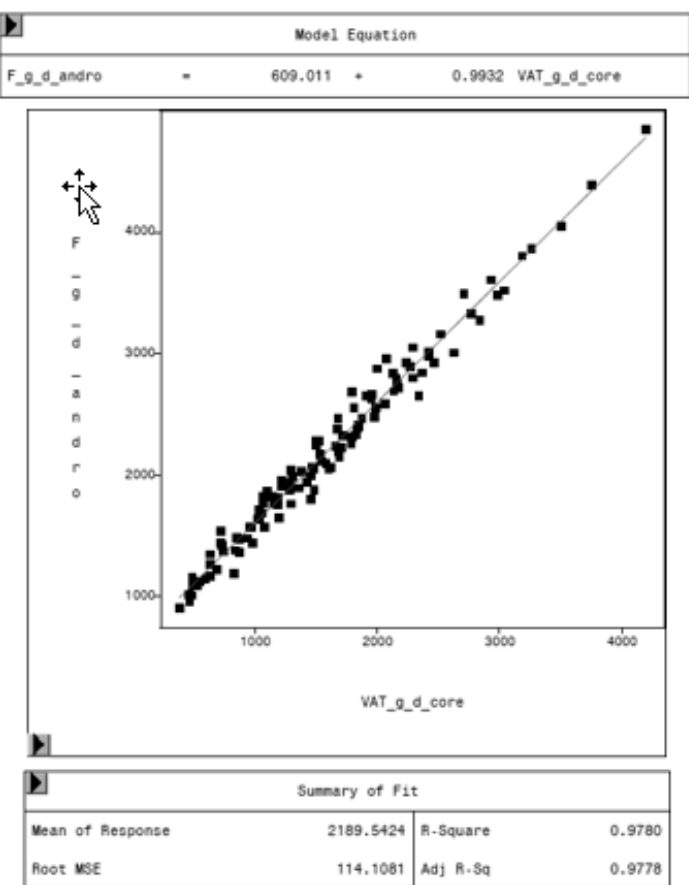
Figure 7. Relationship between fat mass in the android region (F_g_d_andro, in g) and VAT mass (VAT_g_d_core, in g) in “thick” mode, measured by DXA. Regression analysis shows the difference in total fat mass in the android region and VAT. The difference represents the mass of subcutaneous adipose tissue in the average, around 609 g.